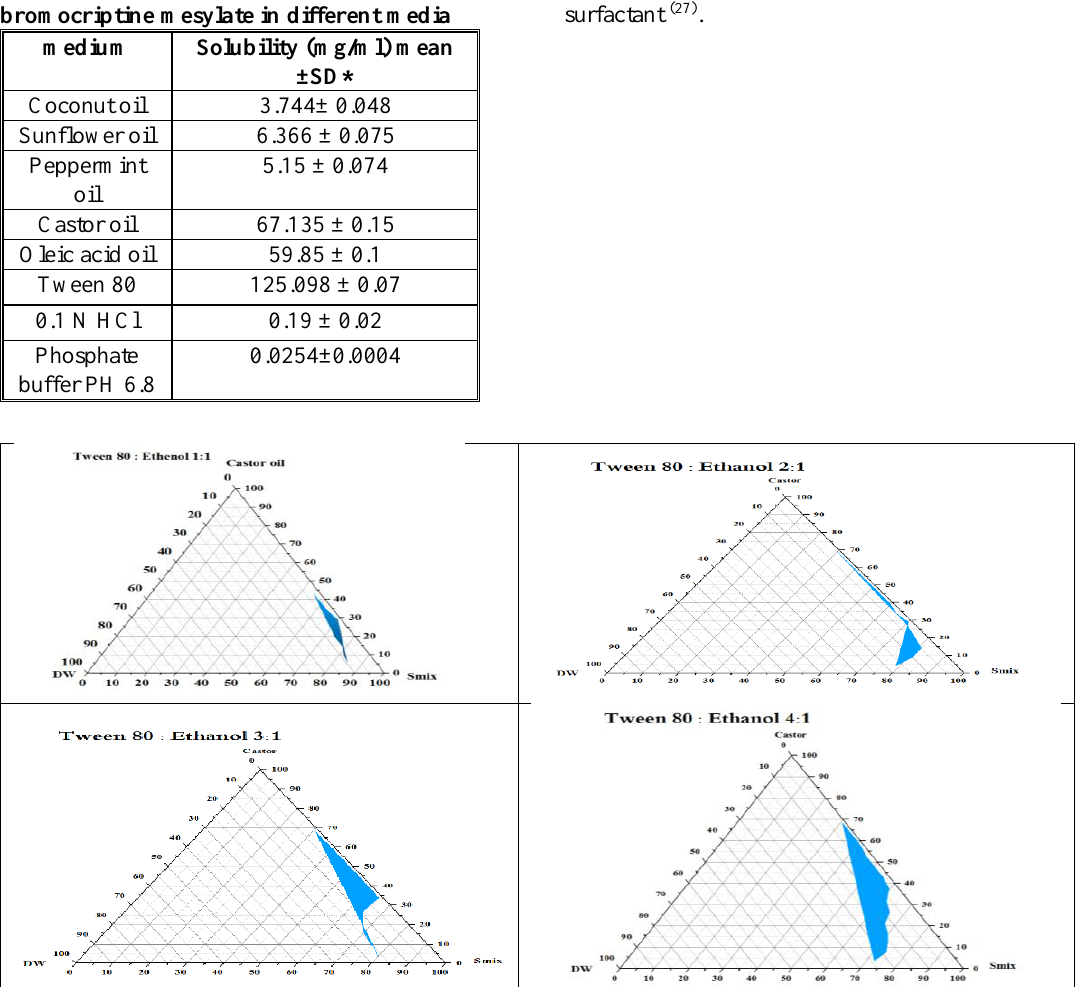
Figure 2 .Pseudo ternary phase diagrams for different S mix ratio (tween 80: ethanol 1:1, 2:1, 3:1, and